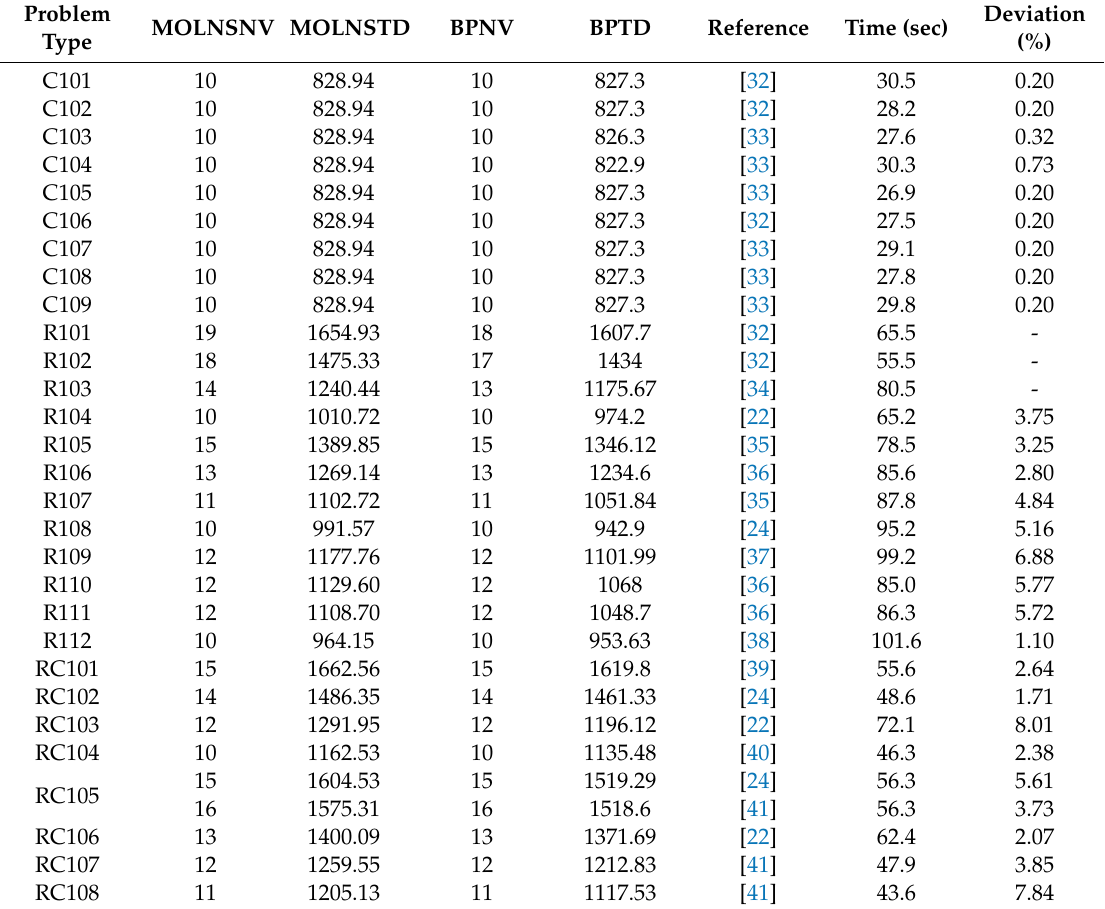
Table 1. Solomon instances with short scheduling horizon: comparison of our MOLNS with the best-published results.